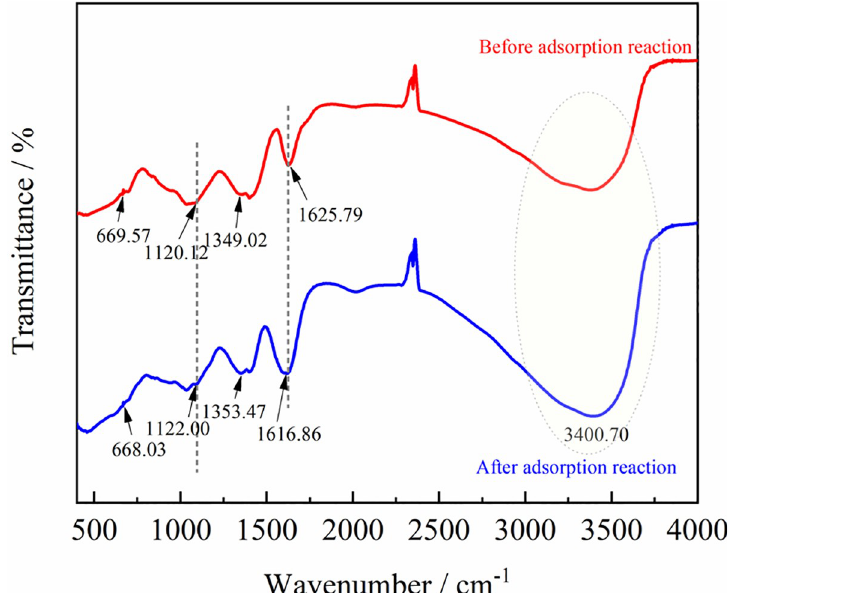
Fig 14. FTIR spectra of ZPC particles before and after the adsorption